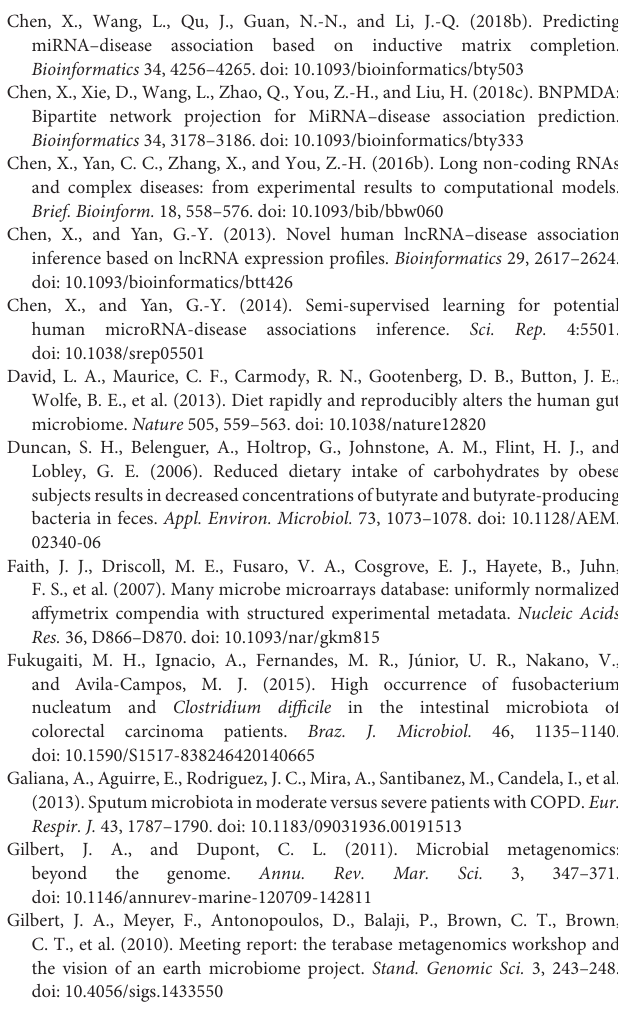
Supplementary Table 1 | Ranks of microbe-disease associations predicted by BWNMHMDA. Supplementary Table 2 | Top 10 related microbes of all